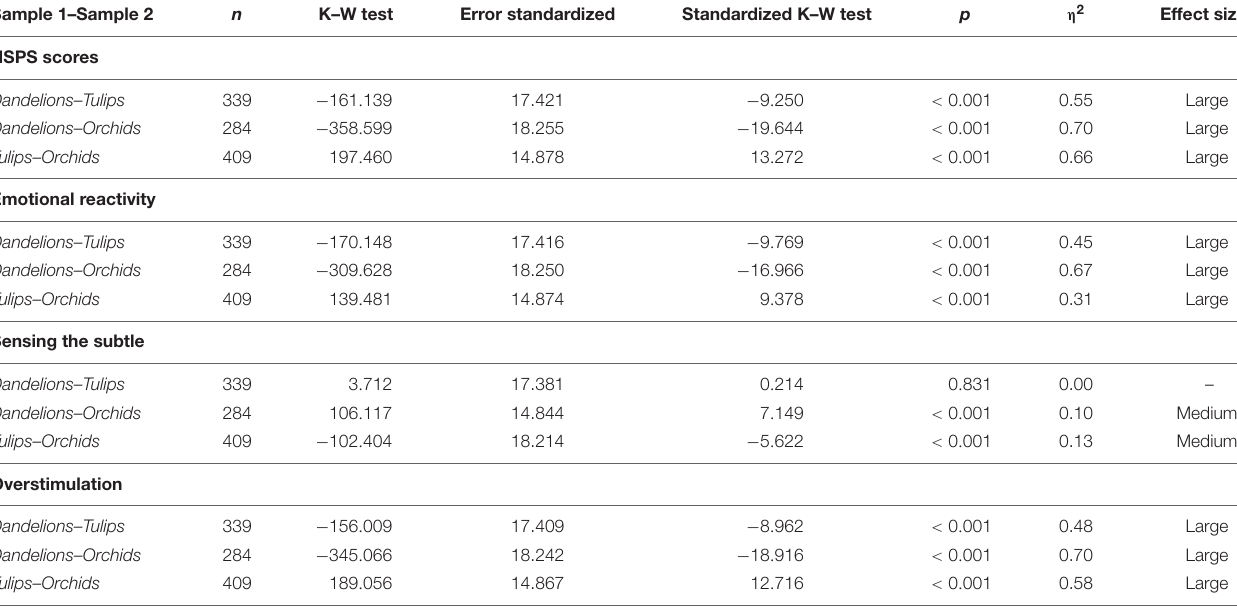
TABLE 4 | The results of the Kruskal–Wallis test on general sensitivity (HSPS scores) and HSPS subscales: Emotional Reactivity , Sensing the Subtle , and Overstimulation